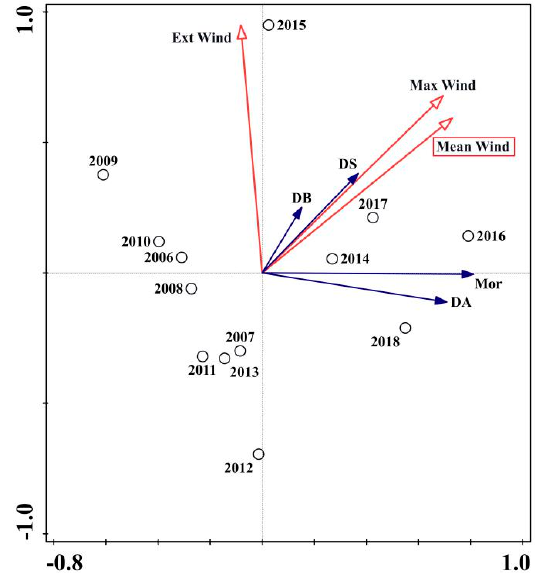
Figure 5. Results of the RDA ordination biplot presenting PWD variables and seven selective relative humidity variables from 2006 to 2018. For PWD epidemic variables (filled arrows): Mor = The quantity of Masson pine mortality; DA = PWD damaged area; DB = The quantity of PWD damaged blocks; DS = The quantity of PWD damaged sites. For relative humidity variables (open arrows): Max humi = Maximum relative humidity during PWD life cycle; Mean humi = Mean relative humidity during PWD life cycle; Min humi = Minimum relative humidity during PWD life cycle; H spring = Relative humidity in the spring quarter (3–5); H summer = Relative humidity in the summer quarter (6–8); H autumn = Relative humidity in the autumn quarter (9–11); H winter = Relative humidity in the winter quarter (12, 1, 2).